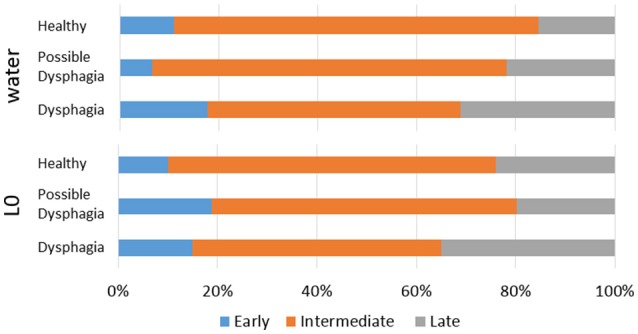
Distributions of timings of swallow in the respiratory cycle in healthy, possible dysphagic, and dysphagic subjects. Upper panel: water swallows; Lower panel: Level 0 dysphagia diet (L0) swallows.